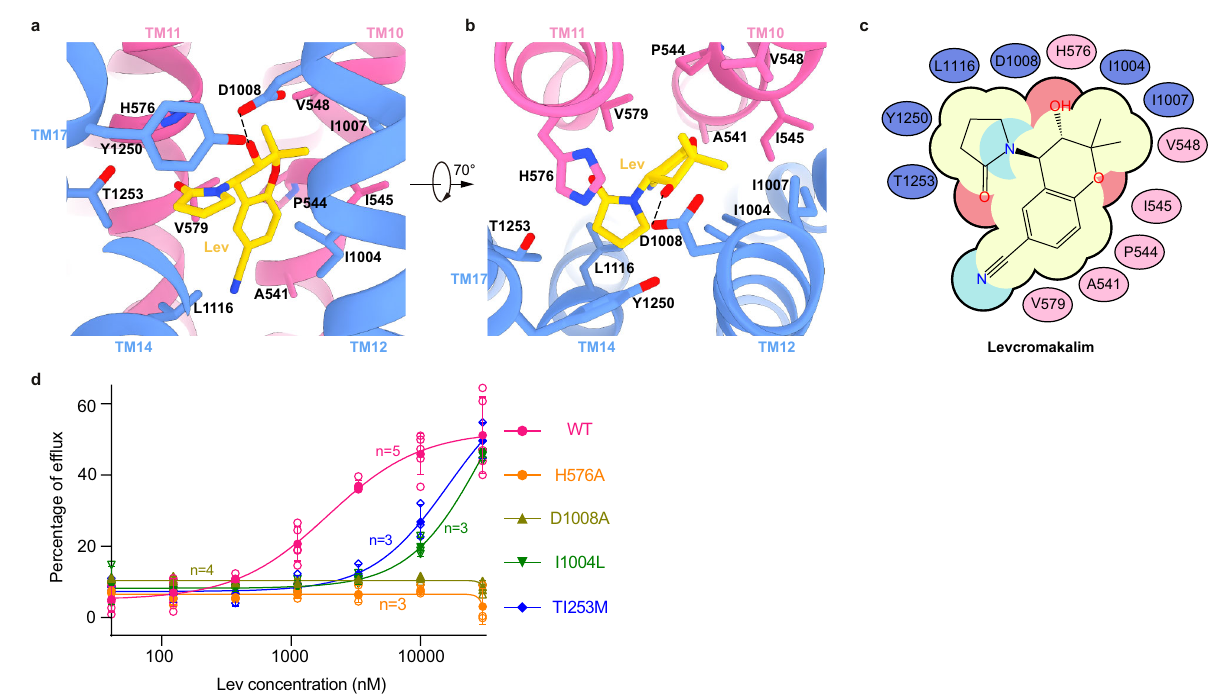
Fig. 3 Lev-binding site in SUR2B. a , b Close-up views of the Lev-binding site. TMD1 and TMD2 are colored in pink and blue, respectively. Lev (yellow) and residues that interact with Lev are shown as sticks. Putative H-bonds are shown as dashed lines. c Cartoon representation of the interactions between Lev and SUR2B. The residues on TMD1 and TMD2 are represented as pink and blue ovals, respectively. d Dose – response activation curves of SUR2B- Kir6.2 K ATP channel by Lev measured by Rb + ef fl ux assay. Curves were fi tted to the Hill equation. Data are presented as mean values ± SD. The numbers of independent experiments of WT, H576A, D1008A, I1004L and T1253M are 5, 3, 4, 3 and 3, respectively. Source data are provided as a Source Data fi le.